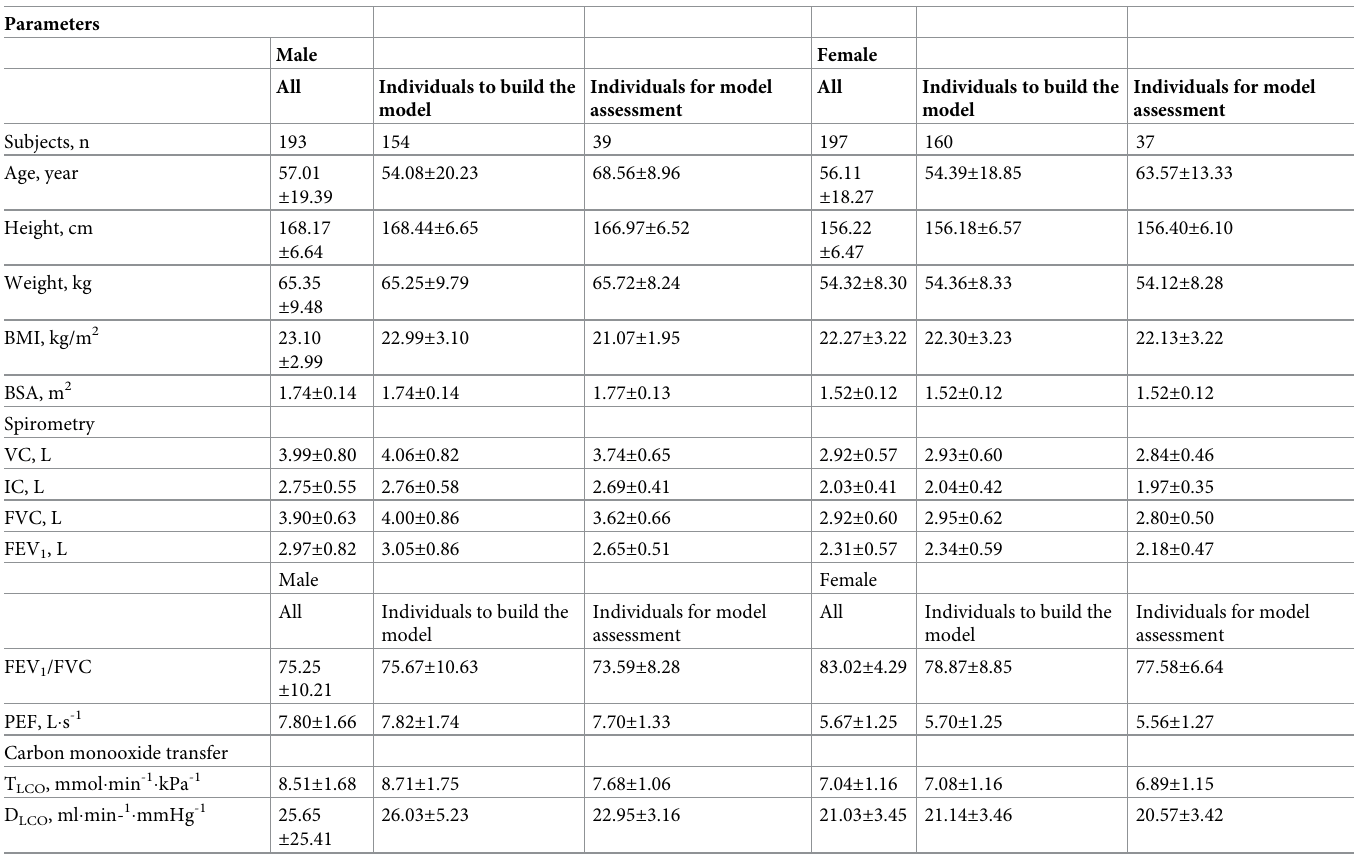
Table 1. All parameters of the study population grouped according to their sex.